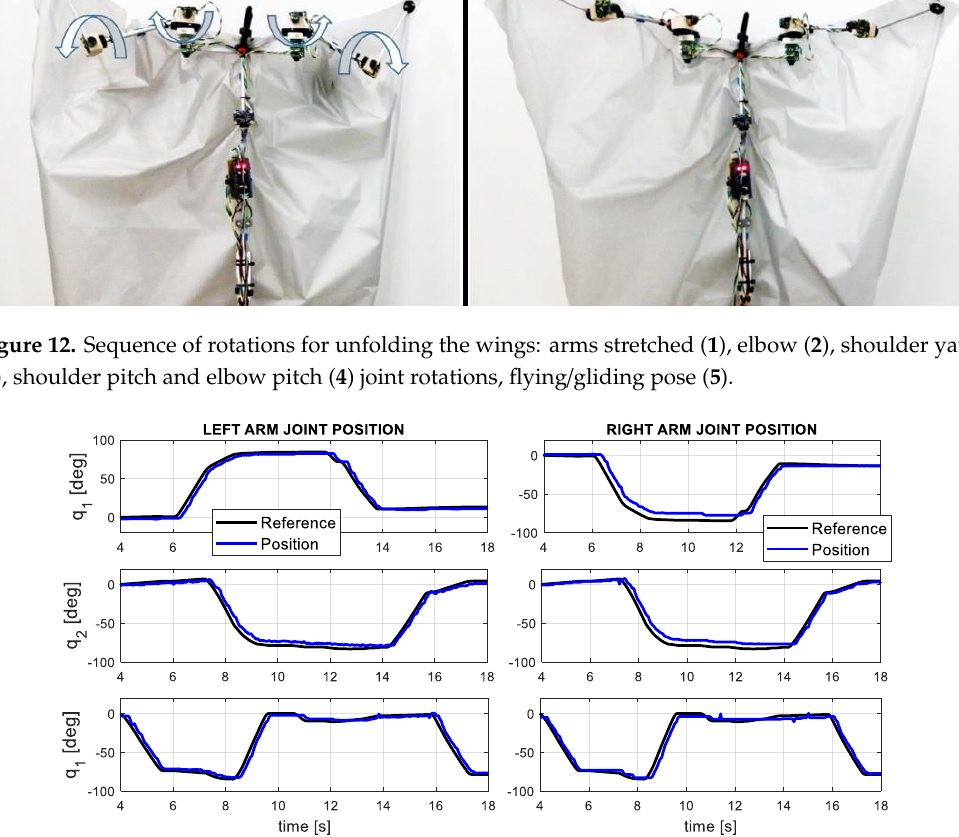
Figure 13. Evolution of the joint angles of the dual arm during the morphing transition.